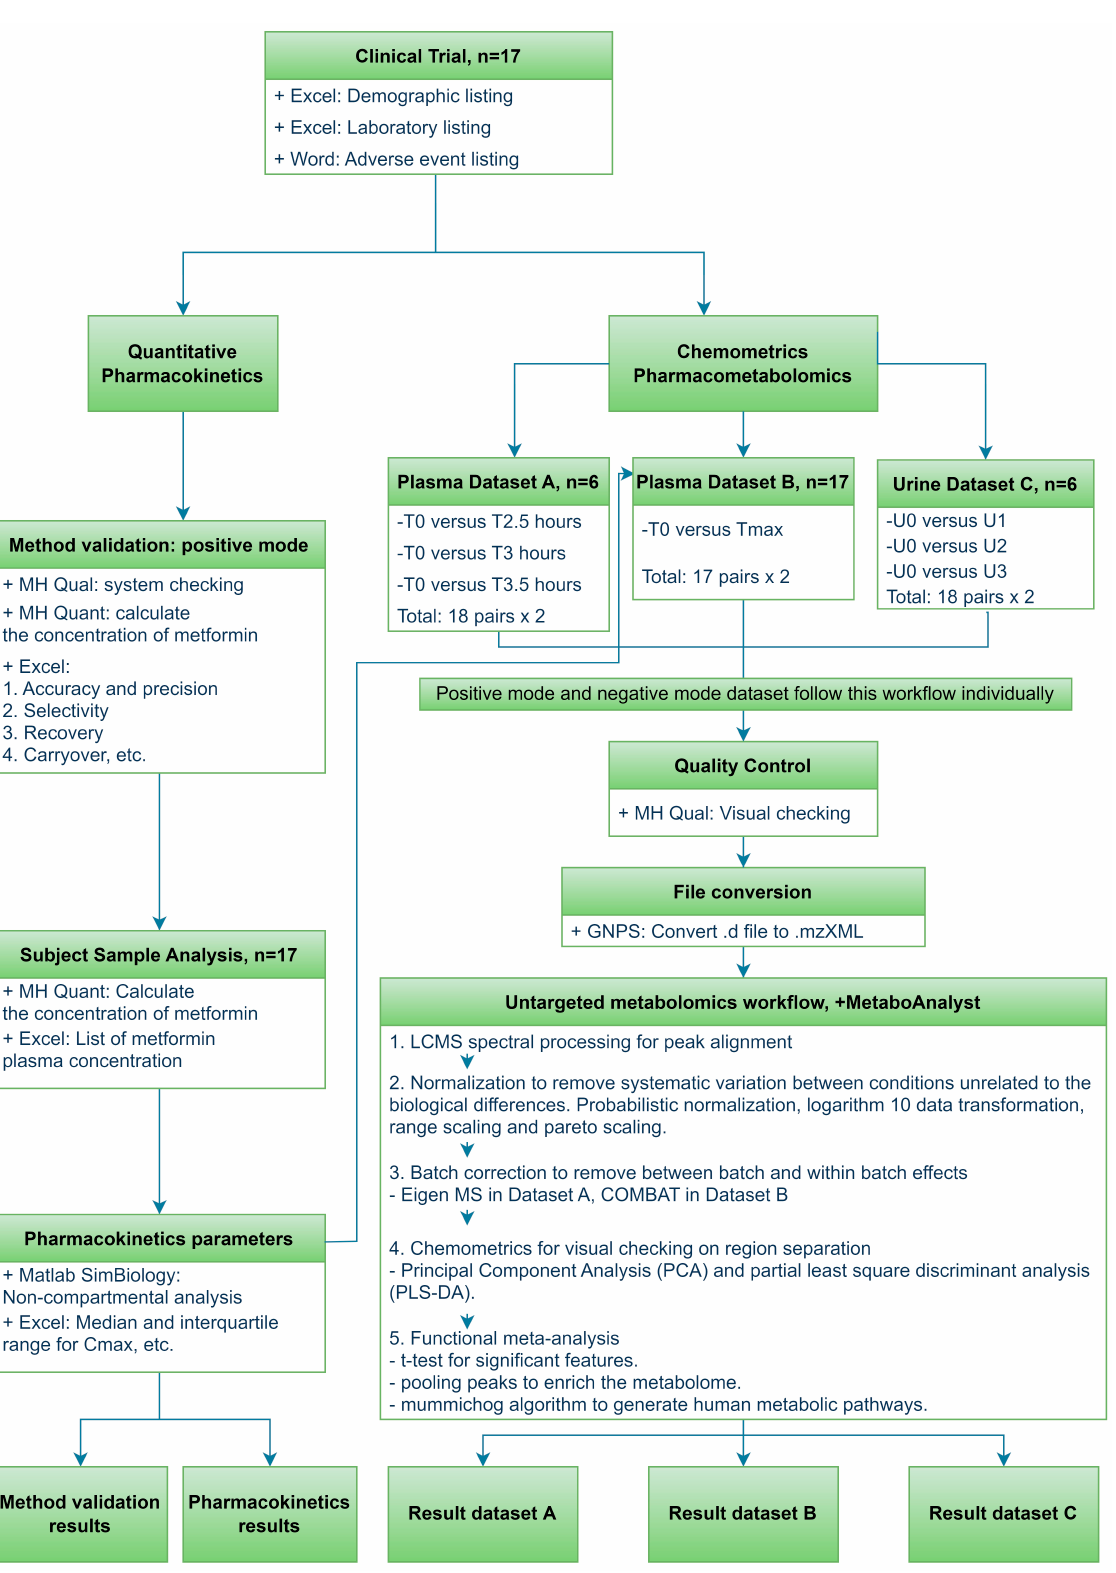
Figure 1. Software and statistical analysis workflow for clinical part, pharmacokinetics and pharmacometabolomics. + name the software used.